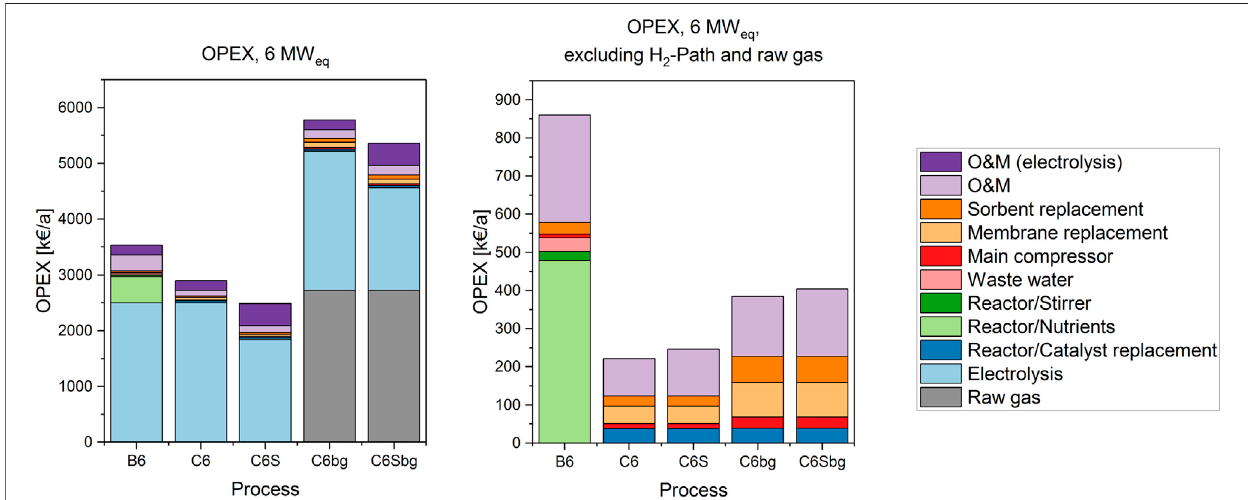
FIGURE6| Operationcost(OPEX)ofthe6MW el processesink € peryear.TheOPEXincludingtheH 2 -pathareshowninontheleft,therightsideshowsthecost structure without the H 2 -path and the corresponding O&M cost.